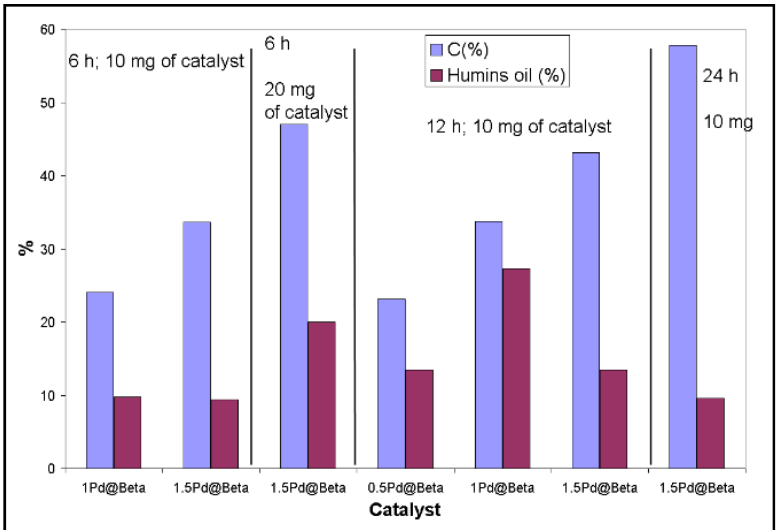
Figure 13. Catalytic performances of the Pd@Beta catalysts in the hydrodeoxygenation of humins (reaction conditions: 0.1 g humins, 8 mL IPA, 30 bars, T = 250 °C).